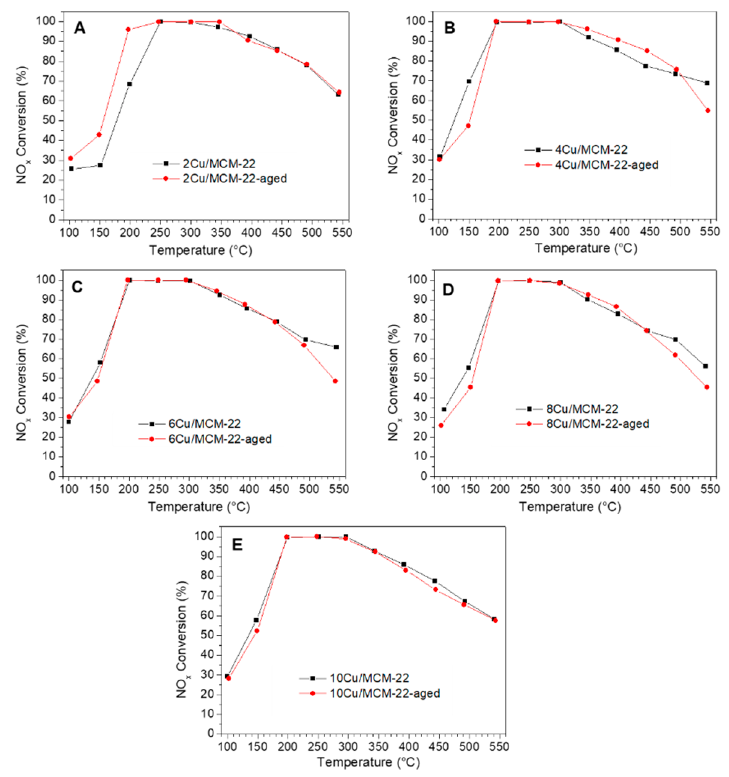
Figure 9. Comparison of NH 3 -SCR activity of x Cu/MCM-22 (before hydrothermal aging) and x Cu/MCM-22-aged (after hydrothermal aging) with different Cu contents: ( A ) 2Cu/MCM-22 and 2Cu/MCM-22-aged; ( B ) 4Cu/MCM-22 and 4Cu/MCM-22-aged; ( C ) 6Cu/MCM-22 and 6Cu/MCM-22-aged; ( D ) 8Cu/MCM-22 and 8Cu/MCM-22-aged; ( E ) 10Cu/MCM-22 and 10Cu/MCM-22-aged.